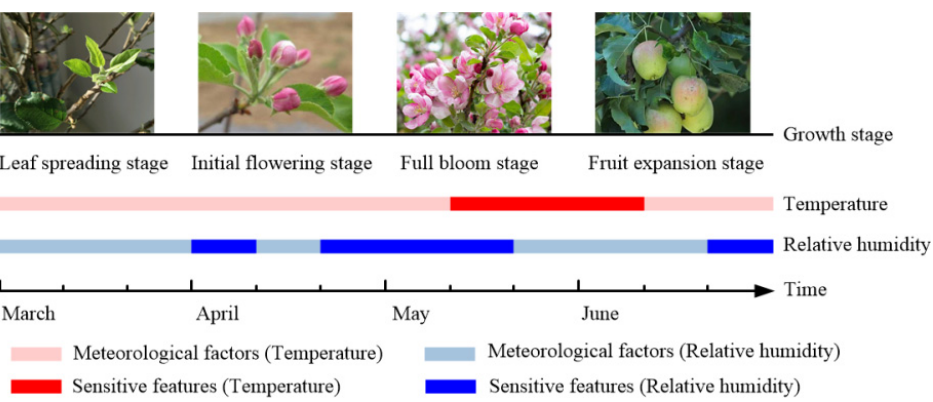
Figure 7. Sensitive features selection of meteorological data from leaf spreading stage (March) to fruit spreading stage (June).